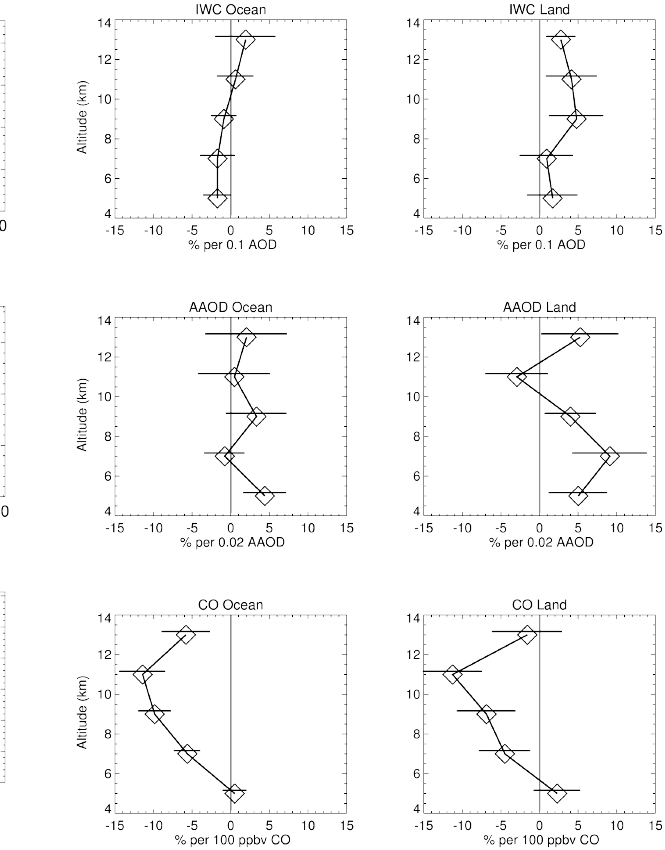
Figure 13. Histograms of IWCshape derivatives for AOD, AAOD, and CO bins, when the derivatives are less than 100% per 0.10 AOD, 100% per 0.02 AAOD, and 100% per 100ppbv CO, respec- tively. Means of the distributions are indicated by the numbers in each panel’s title. Averages pertain to the 7–15km altitude range.